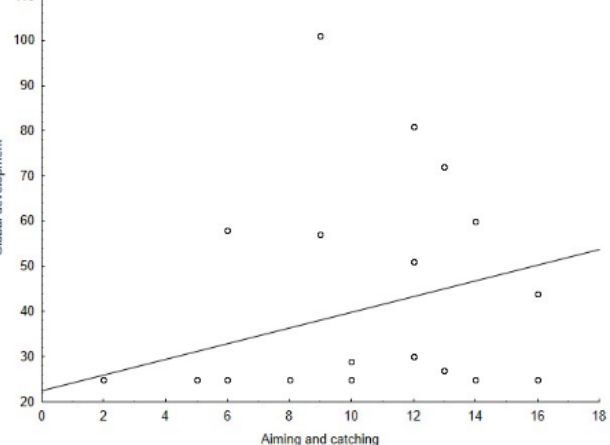
Figure 2. Correlation between adaptive behavior development area of the DP-3 and global motor coordination of the M-ABC.